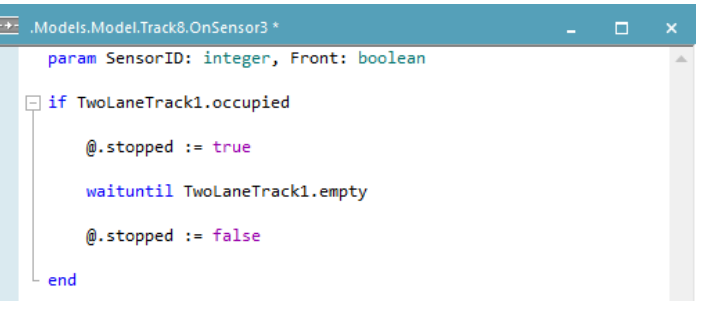
Figure 11. Connector method for stopping and starting the vehicle at the crossing.